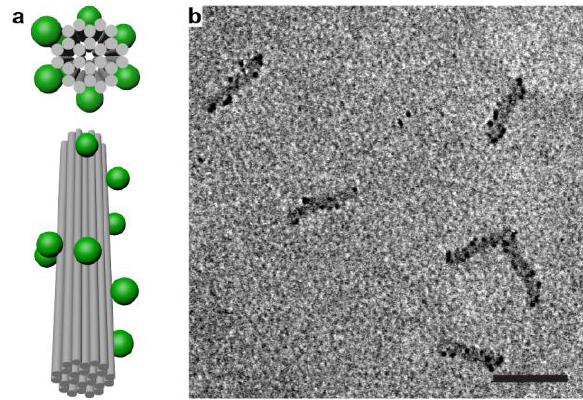
Figure 4. QDs assembled into chiral (here left-handed) helices. ( a ) Top and side view of the chiral QD assemblies on a 24-HB DNA origami; ( b ) TEM image of unstained 24-HB with helical assemblies of CdSeS/ZnS particles. Scale bar: 100 nm.